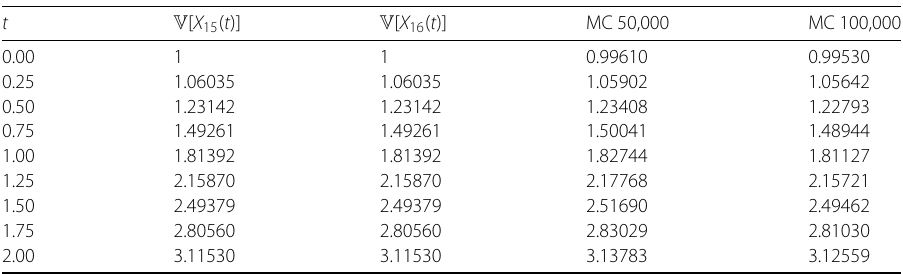
Table 2 Approximation of the variance of the solution stochastic process. Example 4.1, assuming independent random data